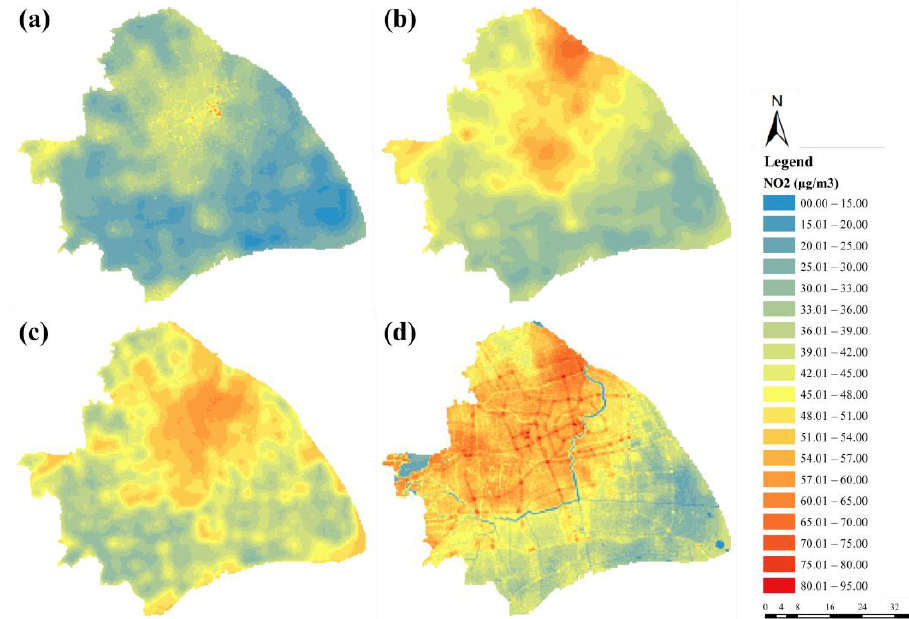
Figure 3. Hourly NO 2 concentration maps of land-use regression predictions during ( a ) daytime